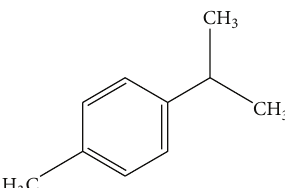
Figure 1: Chemical structure of p